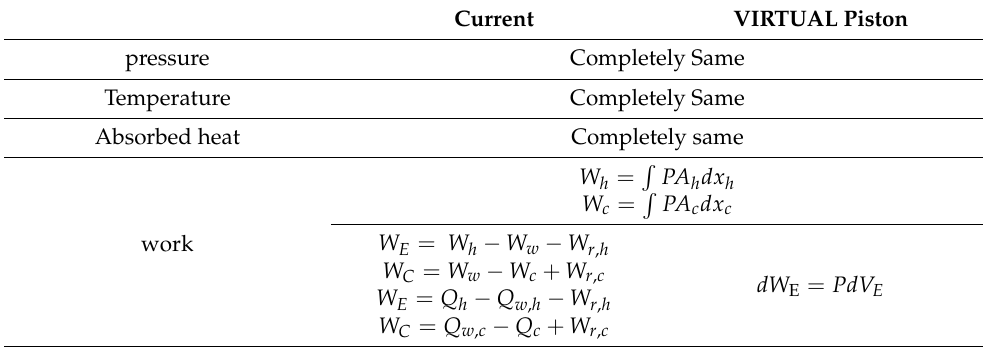
Table 2. Virtual piston based Vuilleumier model and current Vuilleumier